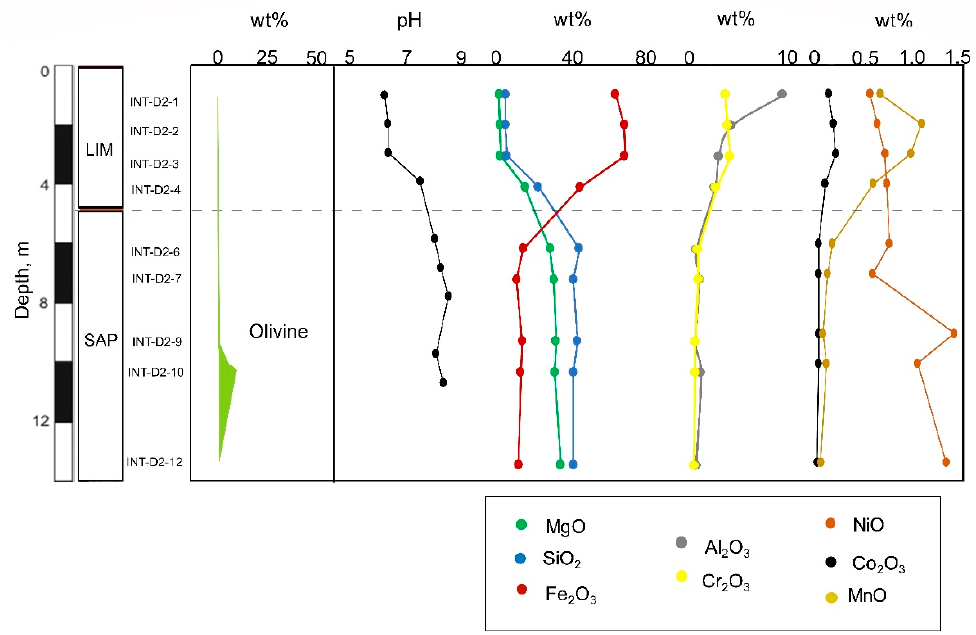
Figure 16. Distribution of olivine, pH and elements with depth in the laterite derived from clinopyroxenite bedrock (PG1500 core).